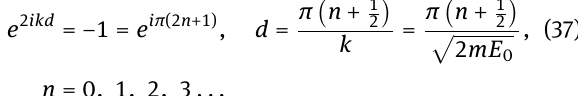
The dashed line on the right side shows, for compari- son, a graph of the reflection coefficient for a single barrier.